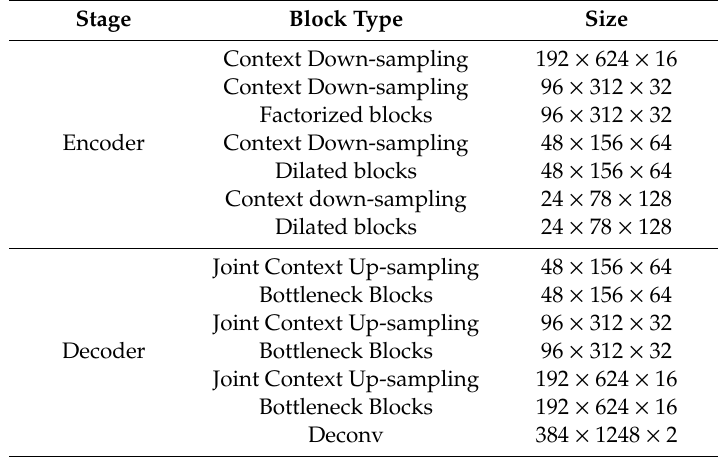
Table 1. Our network architecture in detail. Size refers to output feature maps size for an input size of 384 × 1248.